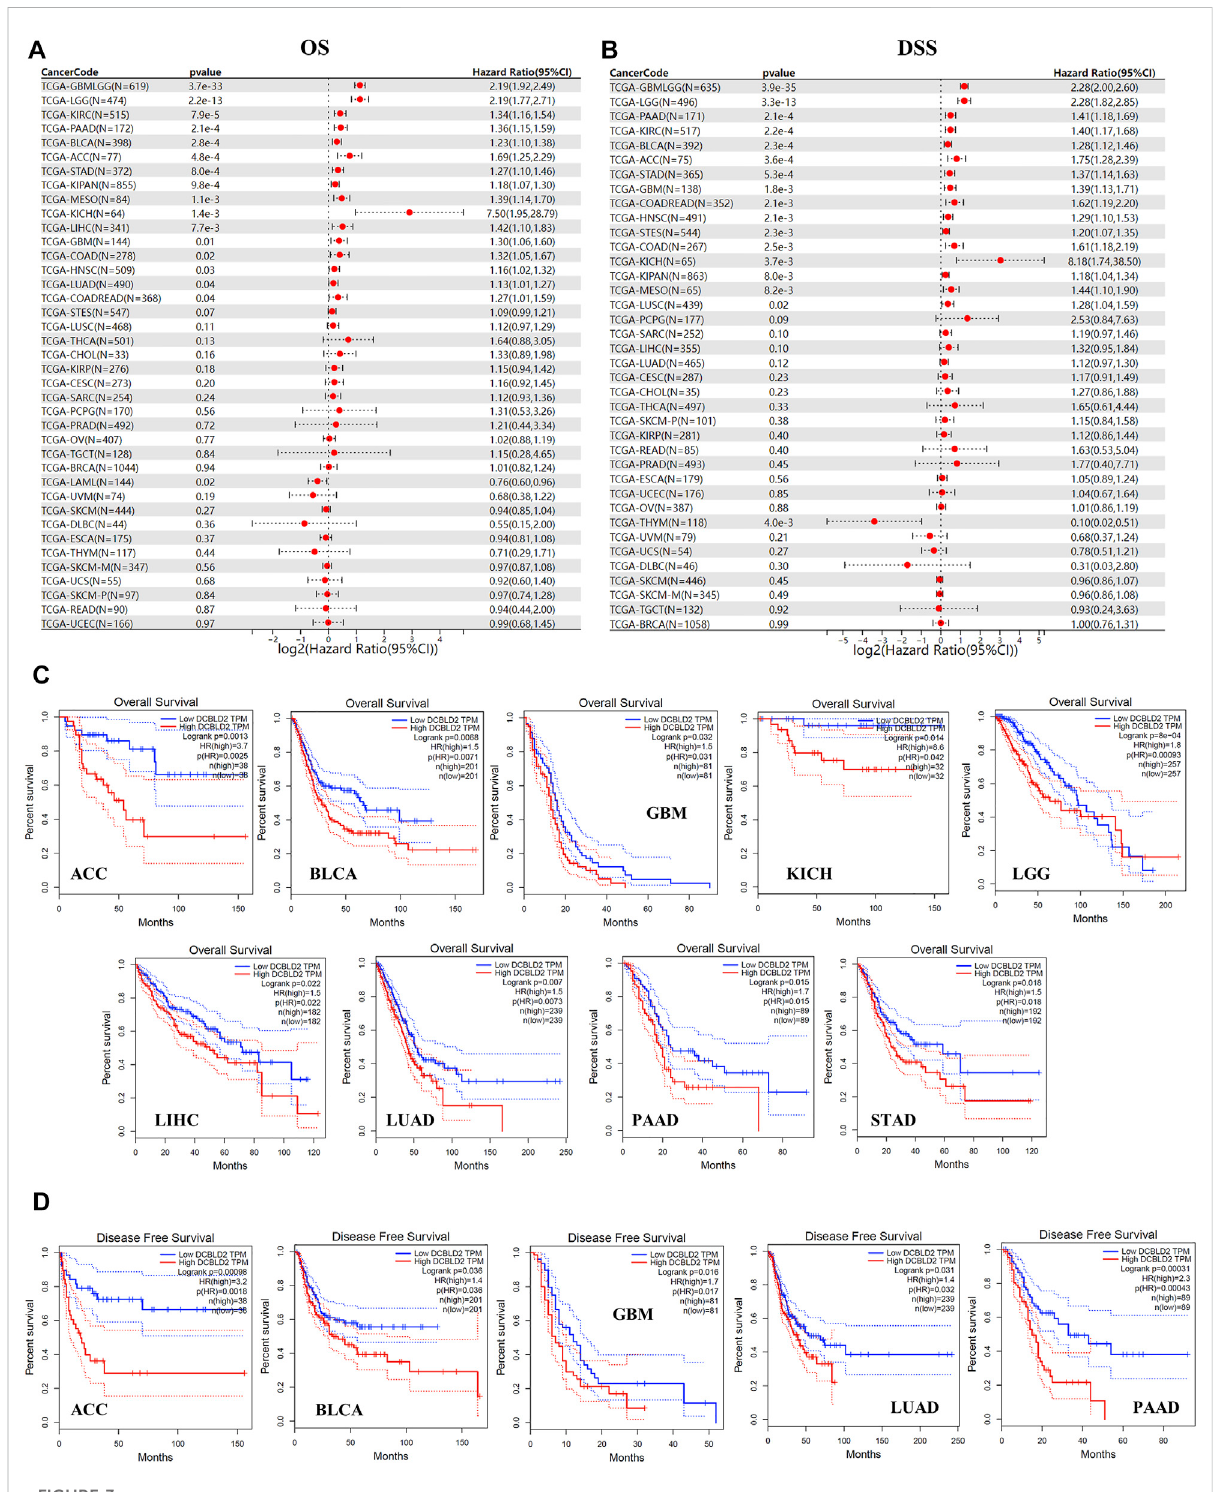
FIGURE 3 Association of DCBLD2 with tumor-poor cancer prognoses. (A) Forest plot showing the correlation between DCBLD2 expression and Overall Survival (OS) in 39 types of tumors as adopted from TCGA data. (B) Forest plot showing the correlation between DCBLD2 expression and Disease- Speci fi c Survival (DSS) in 39 types of tumors as adopted from TCGA data. (C – D) Analysis of the Overall Survival (C) and Disease-Free Survival (D) of multiple tumors based on DCBLD2 expression as adopted from GEPIA 2.0 database (All p <